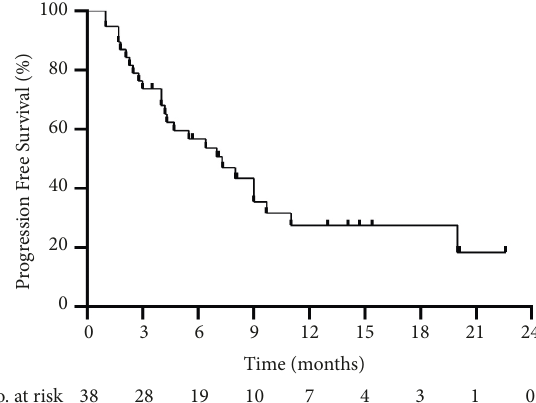
Figure 2: Kaplan–Meier curve of the progression-free survival time of all patients.